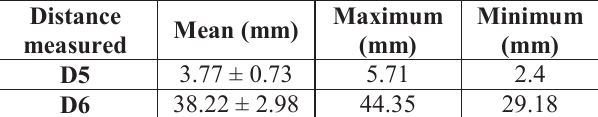
Table 4: Measurements of trochlear spine and fovea in sagittal